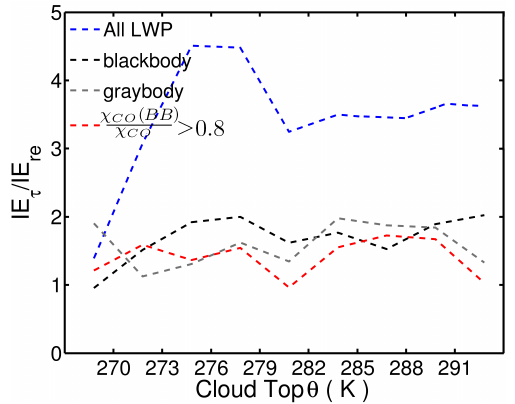
Fig.9. Enhancementof IE τ over IE re asafunctionofpotentialtemperatureandLWP,forlow- Fig. 9. Enhancement of IE τ over IE re as a function of poten- levelliquidcloudsintheArcticfromMarch20toJuly20,2008. Theenhancementsareplotted according to; (blue) all LWP, (gray) graybody clouds with LWP < 40 gm − 2 , (black) blackbody tial temperature and LWP, for low-level liquid clouds in the Arc- clouds with LWP > 40 gm − 2 or (red) with biomass burning (BB) χ CO > 0.8 of the total χ CO tic from 20 March to 20 July 2008. The enhancements are plot- concentrations. 42 ted according to; (blue) all LWP, (gray) graybody clouds with LWP < 40gm − 2 , (black) blackbody clouds with LWP > 40gm − 2 or (red) with biomass burning (BB) χ CO > 0.8 of the total χ CO concentra-